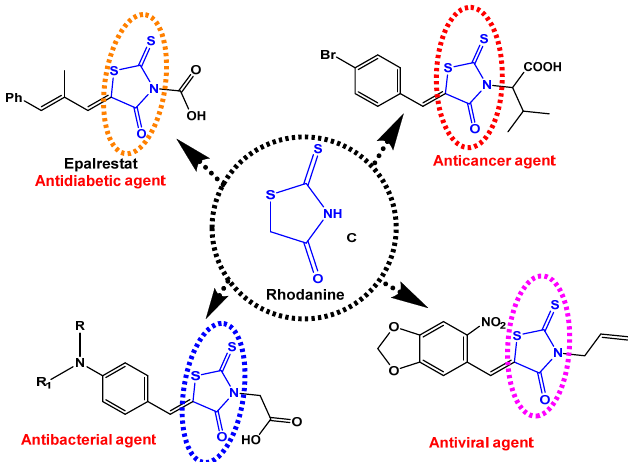
Figure 2. Some biological applications of rhodanine structures C.